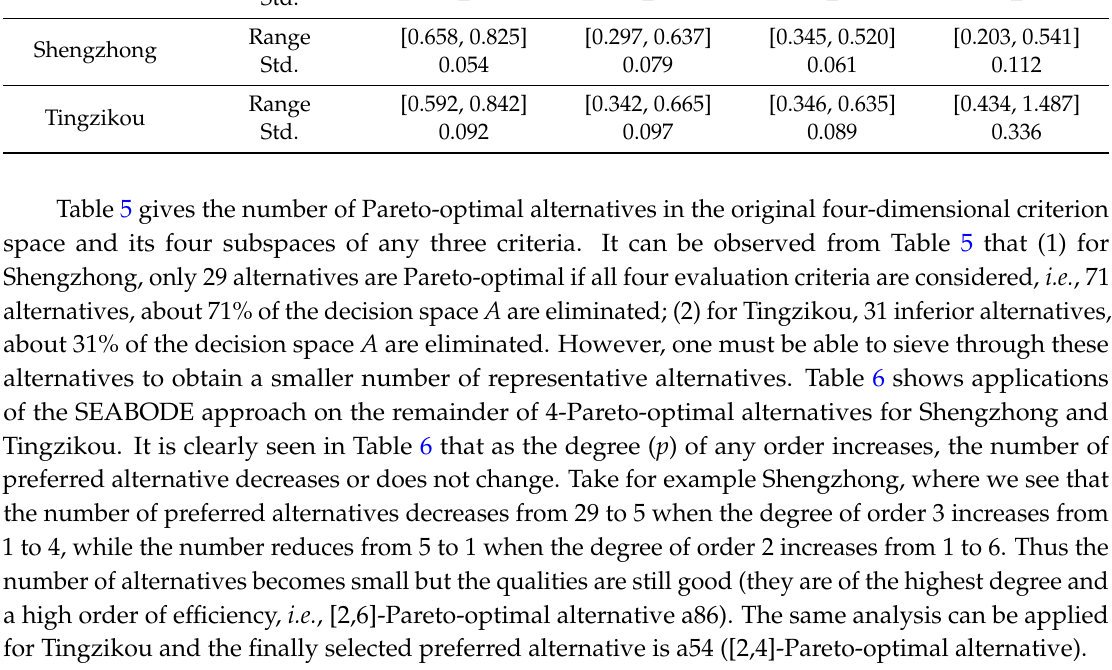
Table 4. Statistics of the specified evaluation criteria for each reservoir in decision space A . Four-Dimensional Criterion Space C Reservoir 1- α 2- γ 3- υ 4-GSI